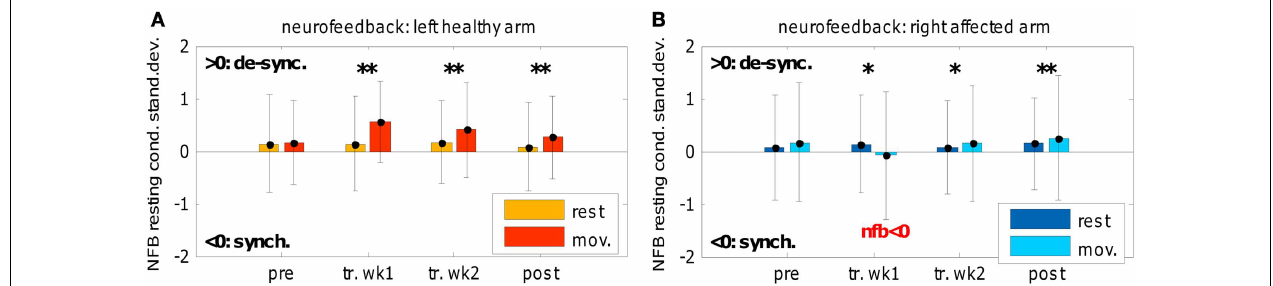
of rest condition standard errors (off-line corrected, without artifacts). Positive values of neuro-feedback reflected a movement-related de-synchronization; between rest and movement conditions only.